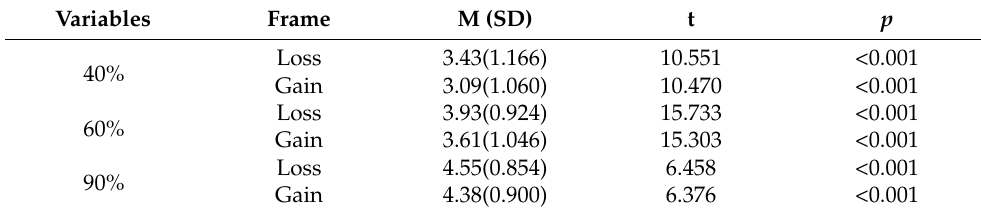
Table 8. Effect of perceived vaccine effectiveness on vaccination